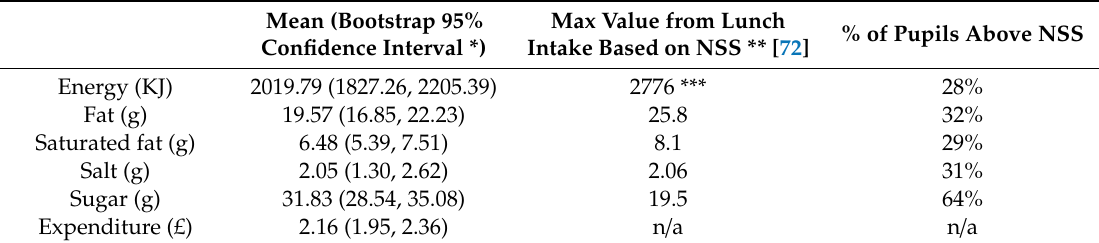
Table 3. Food / drinks intake and expenditure during lunch break outside the school gate on the day of the survey ( N = 243) compared to the Nutrient Standards for School Lunches (NSS) values.